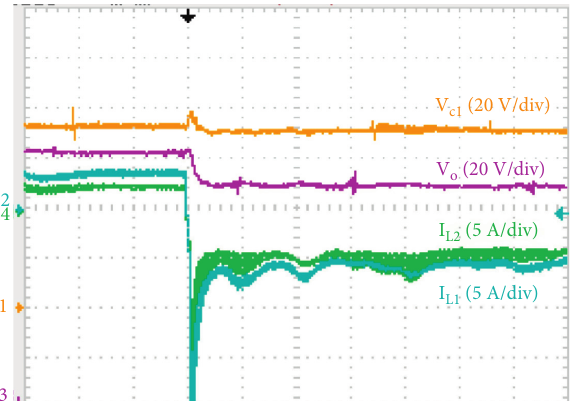
Figure 23: Transition of the motor from motoring mode to regenerative braking mode: V (channel